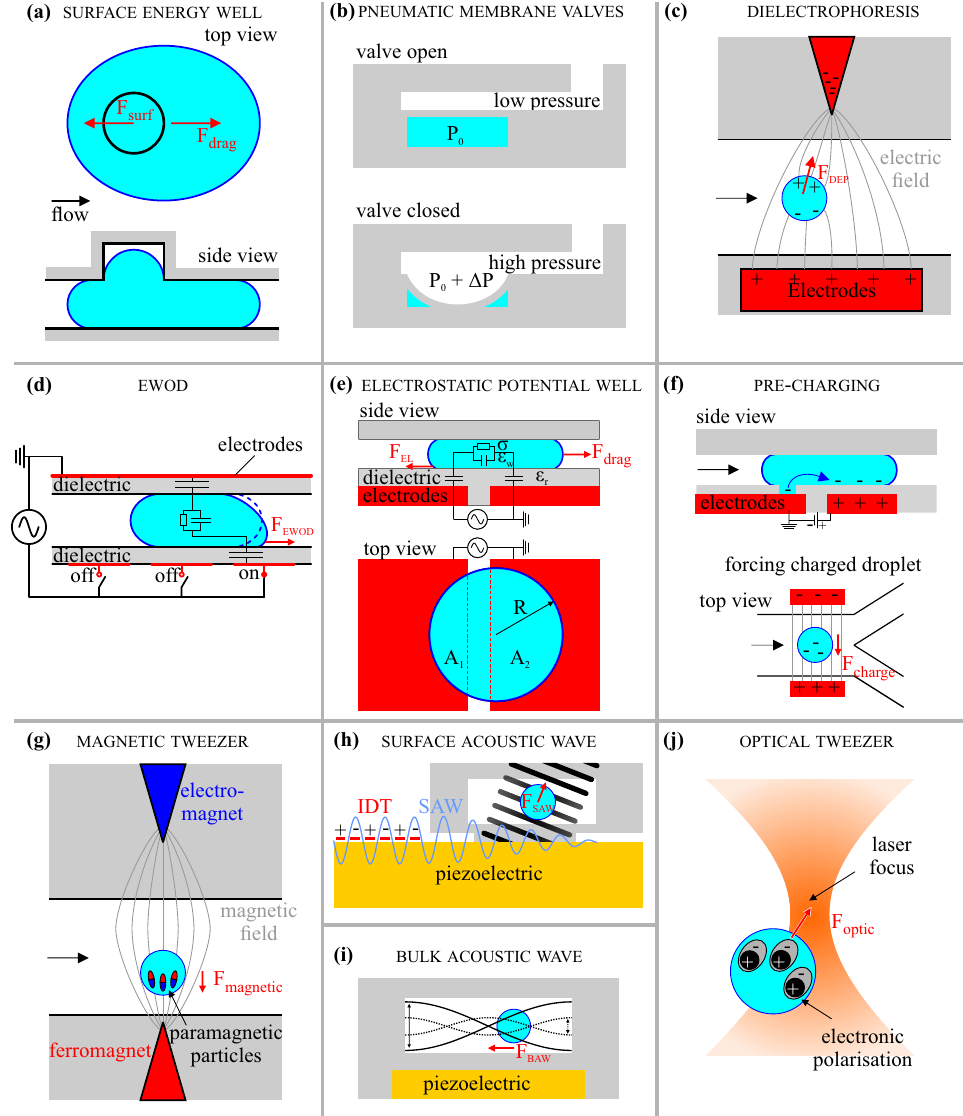
Figure 1. Schematic overview of the droplet manipulation techniques. ( a ) A squeezed droplet can decrease its interfacial energy by expanding in a hole; ( b ) Increasing the air pressure above the local water pressure expands the membrane into the crossing microchannel, effectively blocking it; ( c ) A polarizable medium will move towards the region with highest electric field intensity; ( d ) The electrostatic energy will be minimal when a droplet covers the activated electrode; ( e ) A droplet passing two electrodes finds a minimum energy when centered above the electrodes; ( f ) By taking charges from the open electrode, a droplet can be precharged. A precharged droplet will move towards the oppositely charged electrode; ( g ) Paramagnetic particles move towards the highest magnetic field strength and can drag a droplet along with them; ( h ) The interdigital transducer creates a surface acoustic wave that is attenuated at the PDMS pillar, creating an upward pressure wave that can move droplets; ( i ) At specific frequencies the piezo can create resonating pressure waves in a channel, forcing a droplet towards the antinodes; ( j ) A medium with better polarizability at optical frequencies than the surrounding medium will move towards the region of high intensity laser